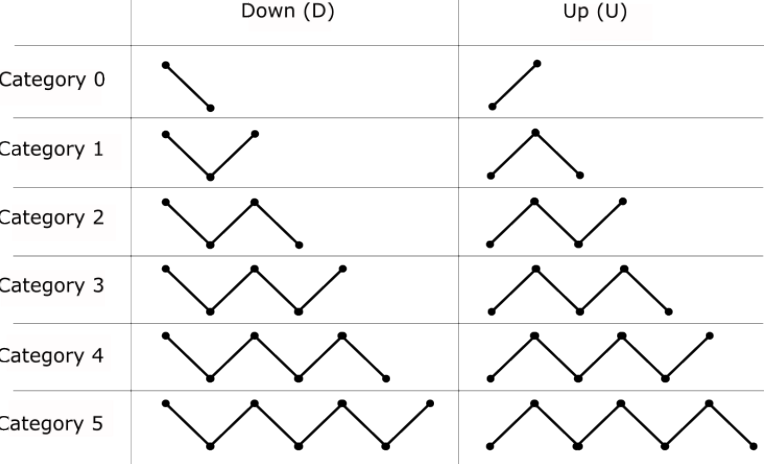
Figure 4. Classification of the whistles detected in both scenarios according to the morphology in the time–frequency (spectrogram) domain. The highest categories correspond to more complex whistles attending the morphology (number of inflection points). The nomenclature Up (U) or Down (D) corresponds to the starting frequency slope of each